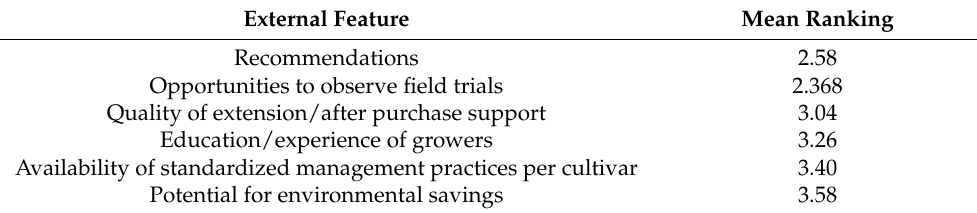
Table 2. Top five most influential external features in tissue culture